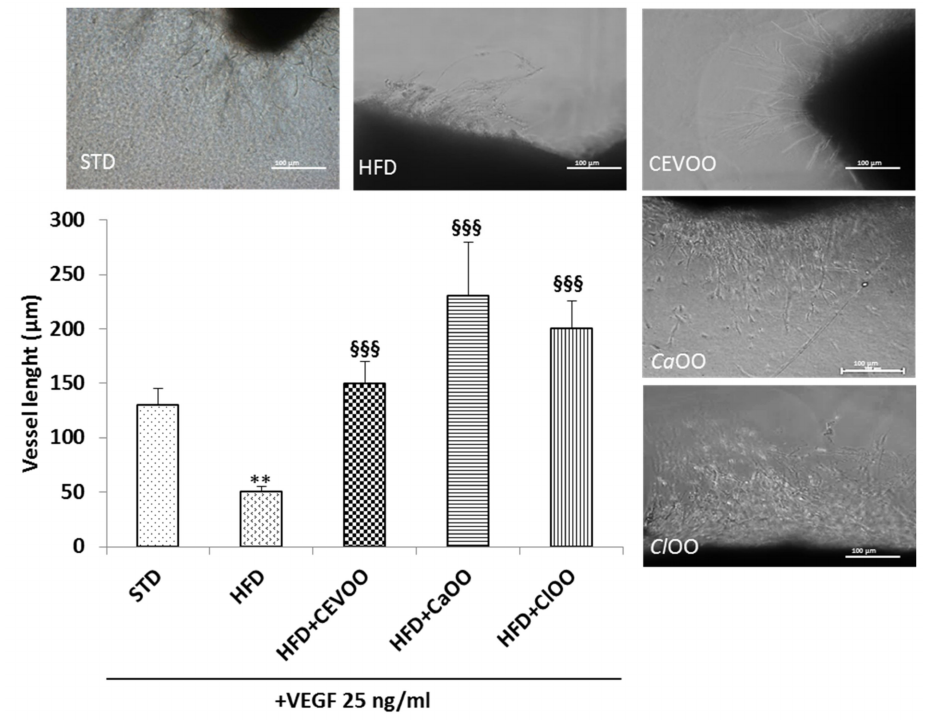
Figure 11. CEVOO, Ca OO and Cl OO promote vessel sprouting from aortic rings of HFD fed rats. Vessel sprouting from rat aorta rings at day 3 of incubation: all groups are treated with VEGF (25 ng / mL). Vessel length is expressed as the number of grid units covering the surface occupied by pseudo-capillaries in